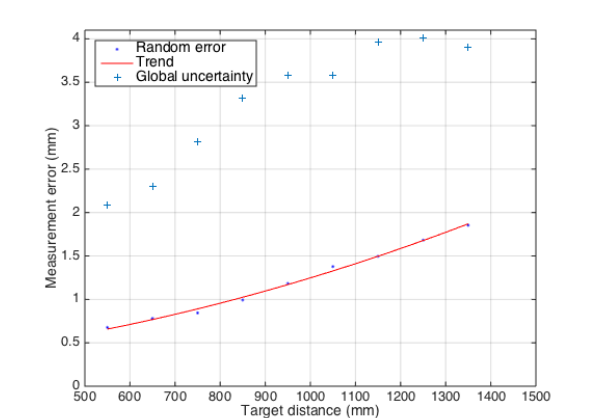
Figure 6. Microsoft Kinect1 global uncertainty (+); random error (dots) and quadratic fitting on the random error (line) exhibiting a correlation factor ρ = 0.9976.